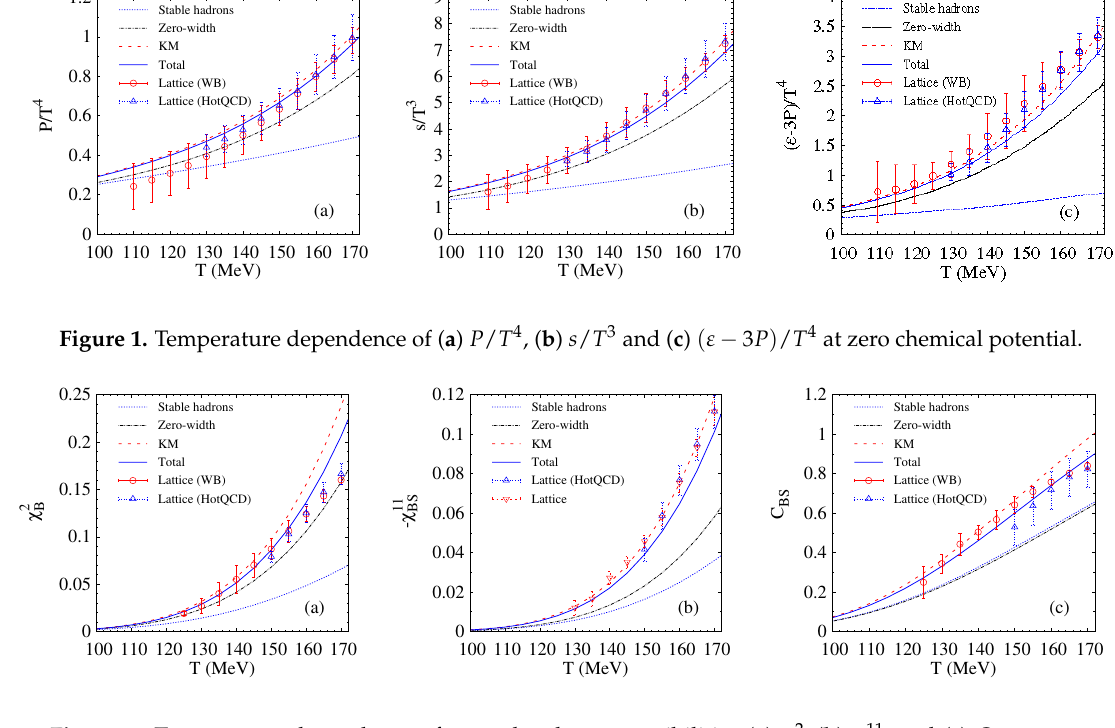
( b ) χ 11 and ( c ) C BS at zero B BS